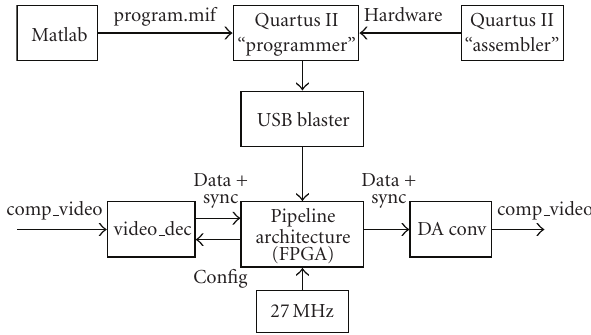
Figure 4: Block diagram of the developed system. After FPGA programming, the composite video is deinterlaced by the video dec, and the 10-bit RGB data produced are processed by the pipeline architecture. The results are converted again to an analog format to be shown in a VGA